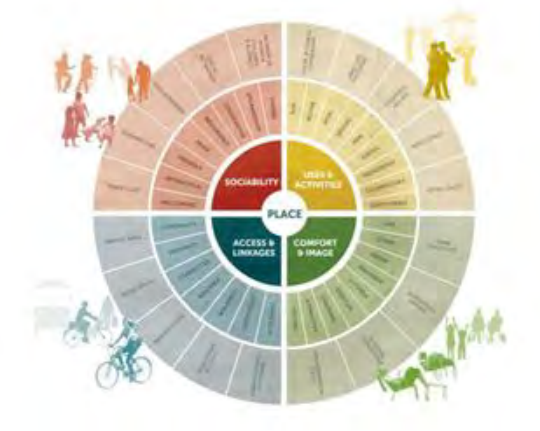
Figure 7. What makes a great place (PPS,